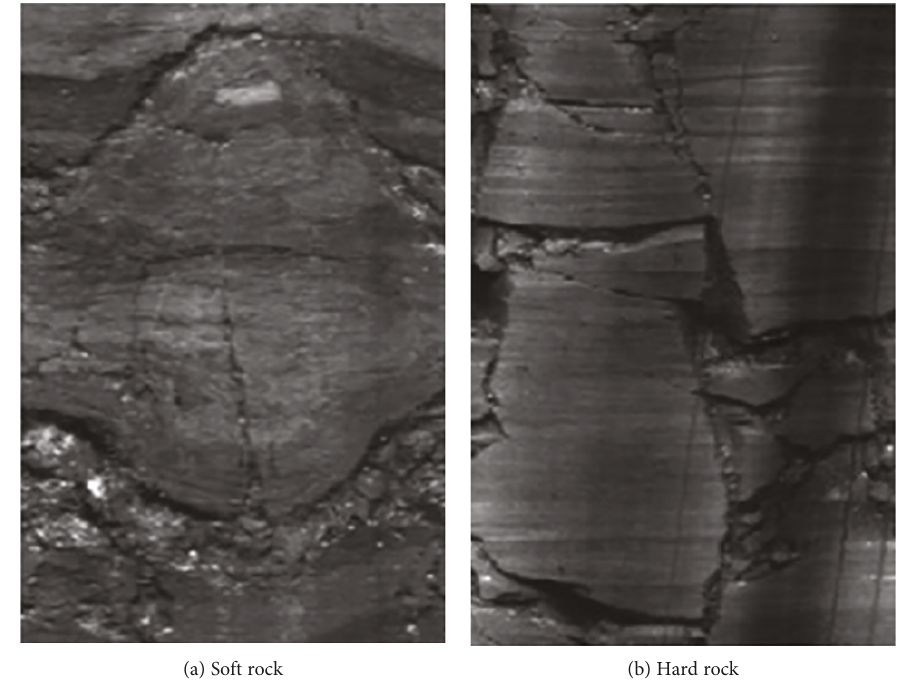
Figure 12: Fracture distribution characteristics between soft and hard rocks after mining.